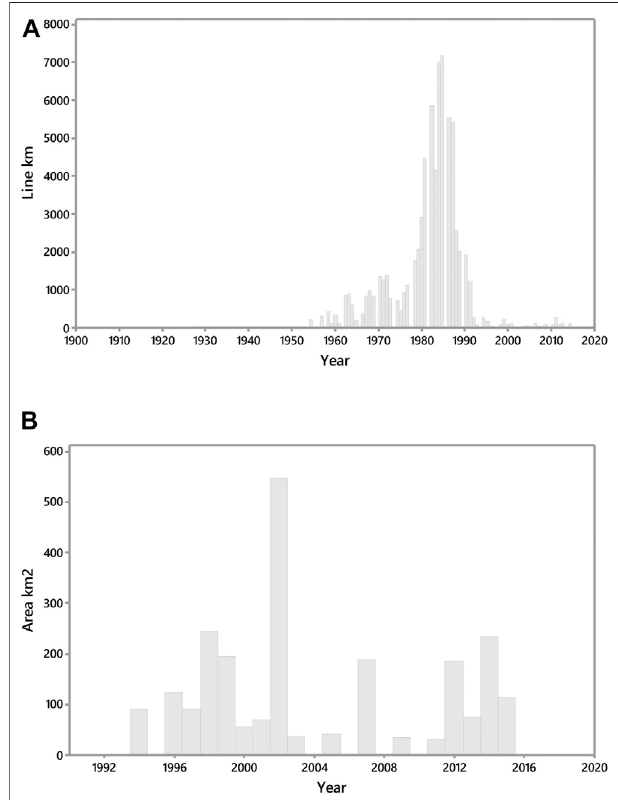
FIGURE 9 | Histograms of (A) length of 2D seismic lines acquired onshore the United Kingdom by year, and (B) area of 3D seismic surveys acquired onshore the United Kingdom by